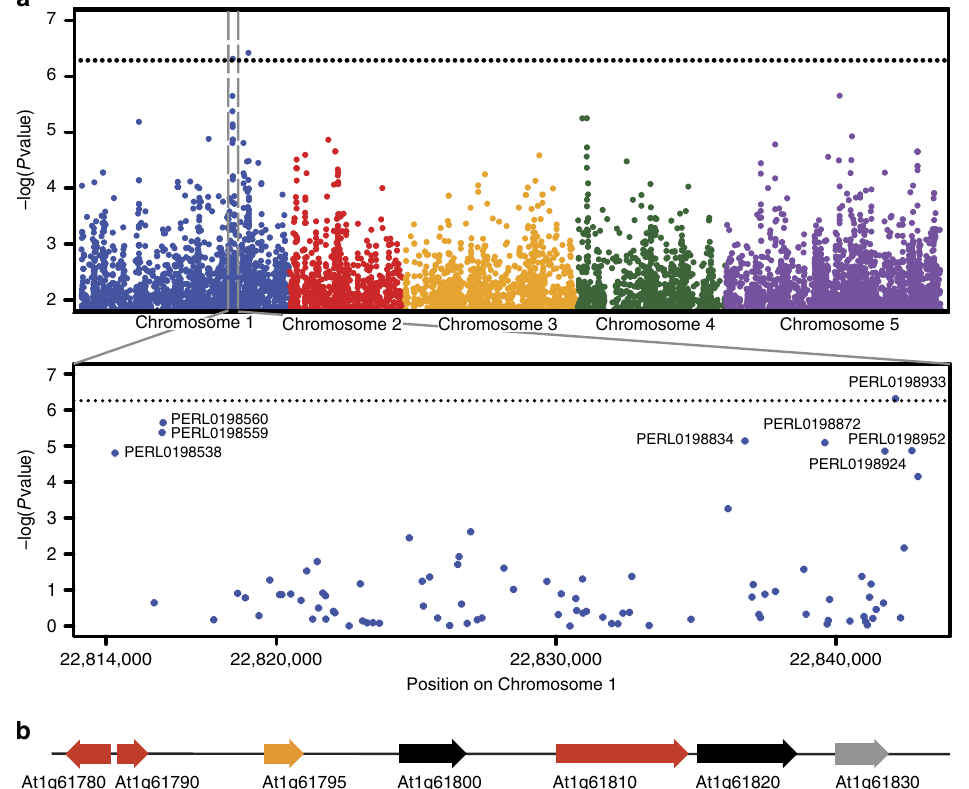
Figure 3 | GWAS identifies an associated region on chromosome 1. ( a ) Manhattan plot showing a peak on chromosome 1 (grey box) with its highest correlated SNP showing significance at P o 0.1 (after Bonferroni correction; dotted line). The peak corresponds to a 28kb region spanning position 22,842,689–22,814,316 (magnified in the second panel). The eight SNPs that were identified to be among the 20 most highly correlated ones in the GWAS are annotated with their PERL identifiers. ( b ) Genes and pseudogenes (grey) in the 28kb region. Genes expressed in synergids are marked in red, genes without available expression data are in orange 32